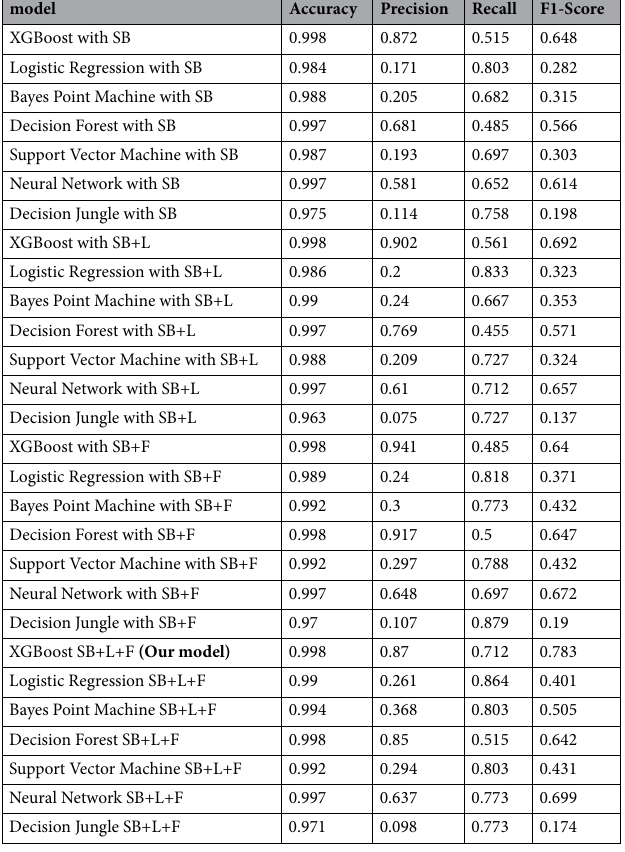
Table 8. Performance using statistics-based features (SB), non-fraud features (L), and fraud features (F). The proposed model uses statistics-based features (SB), non-fraud features (L), and fraud features (F) on